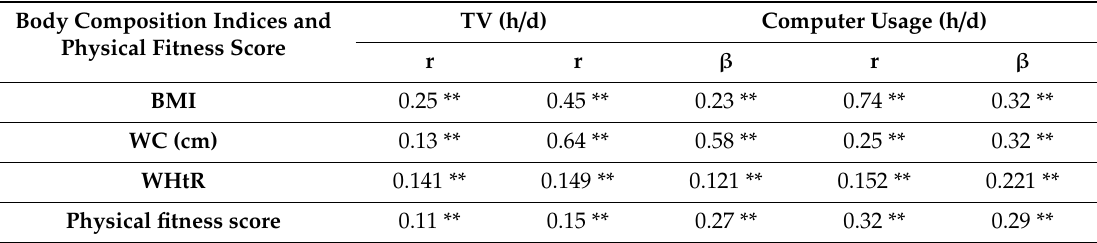
Table 5. Correlation between body composition indices, physical fitness score and media usage among participants using partial correlation and multiple regression analysis.